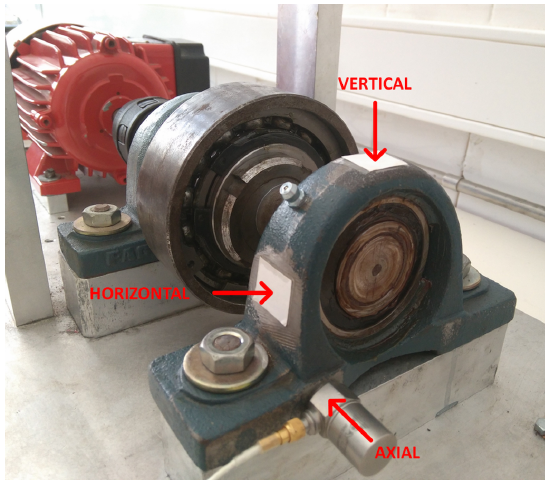
Figure 5. Motor load with 3 locations for fixing the accelerometer for vertical, horizontal and axial